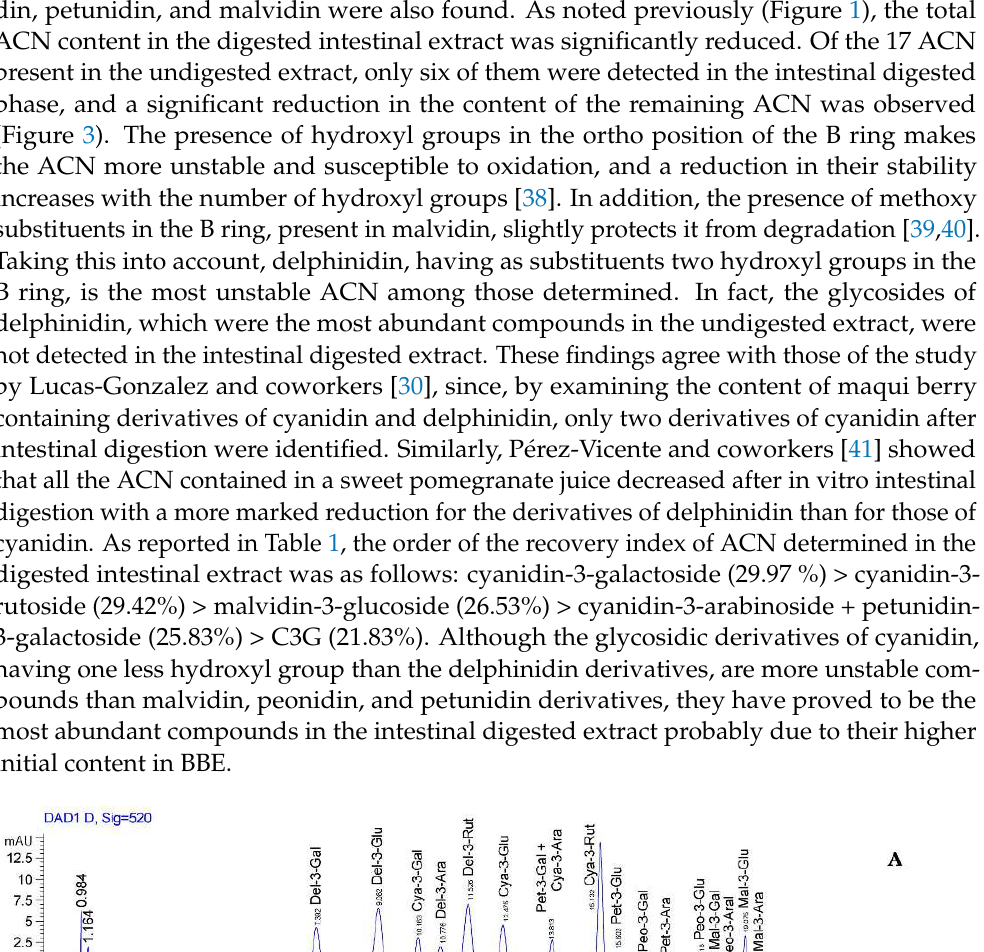
Table 1. Anthocyanins profile and stability of BBE before and after in vitro intestinal digestion, as determined by HPLC/DAD. Data represent peak area (mAU*s) at 520 nm. RI% is the recovery index of each ACN in the intestinal phase vs . the initial content in sham-digested extract. Results are expressed as ± SD of three different experiments a p < 0.05 vs. respective ACN from sham-di- gested extract, b p < 0.05 vs. sham-digested extract.